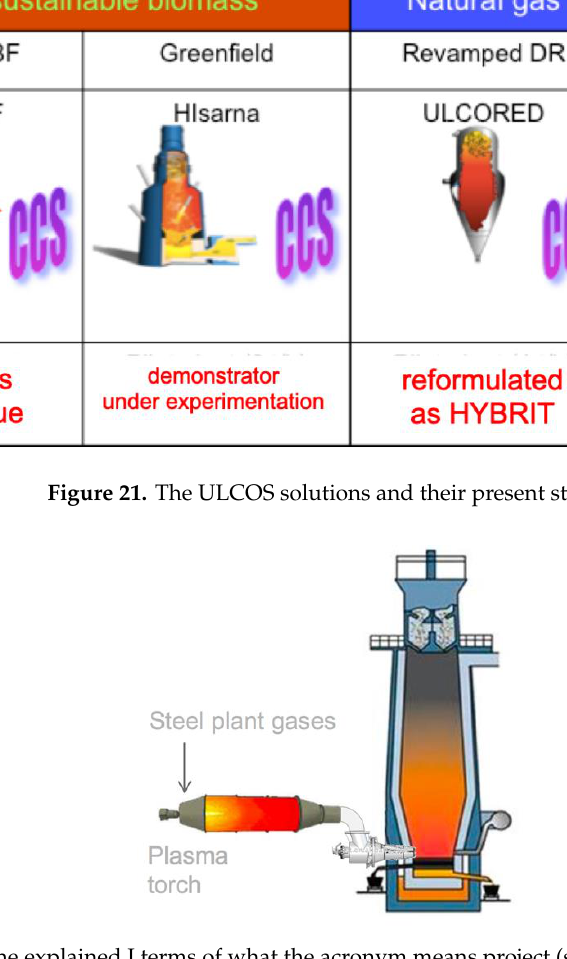
Figure 22. The explained I terms of what the acronym means project (source: ArcelorMittal).